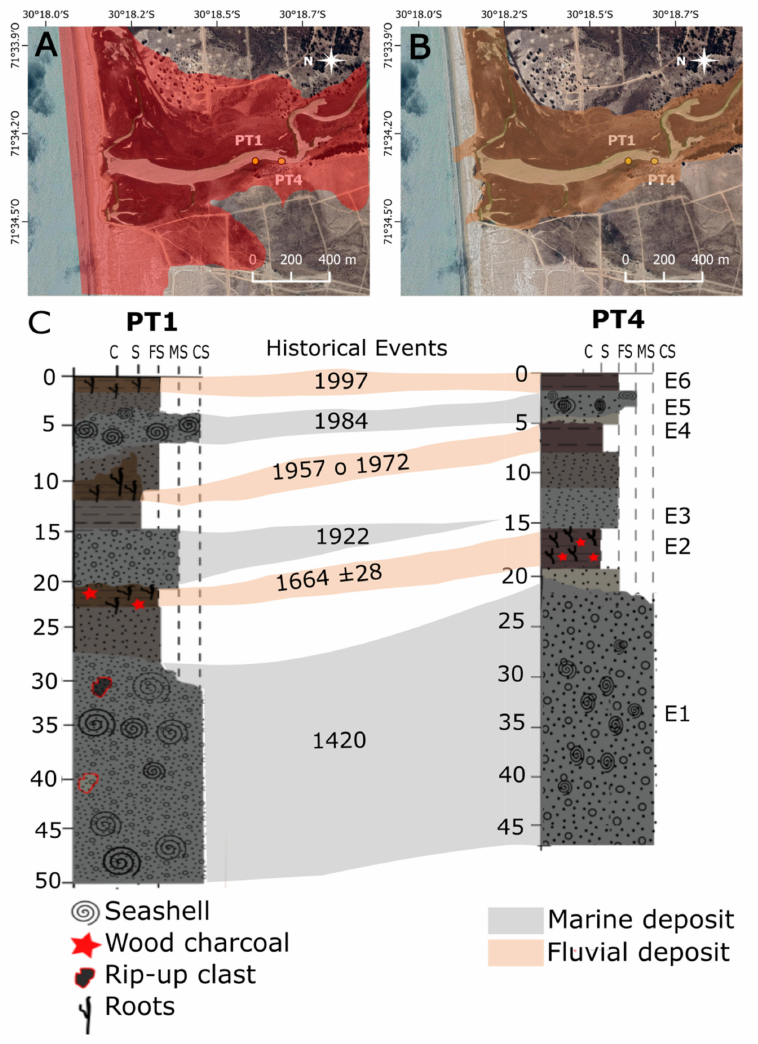
Figure 9. Location of sampling core PT1 and PT4, tsunami flood zone, according to SHOA flood chart ( A ), and the river overflow zone ( B ). ( C ) comparison of sedimentary log between PT1 and PT4 and reconstruction of events (gray layers represent marine events and brown layers represent continental